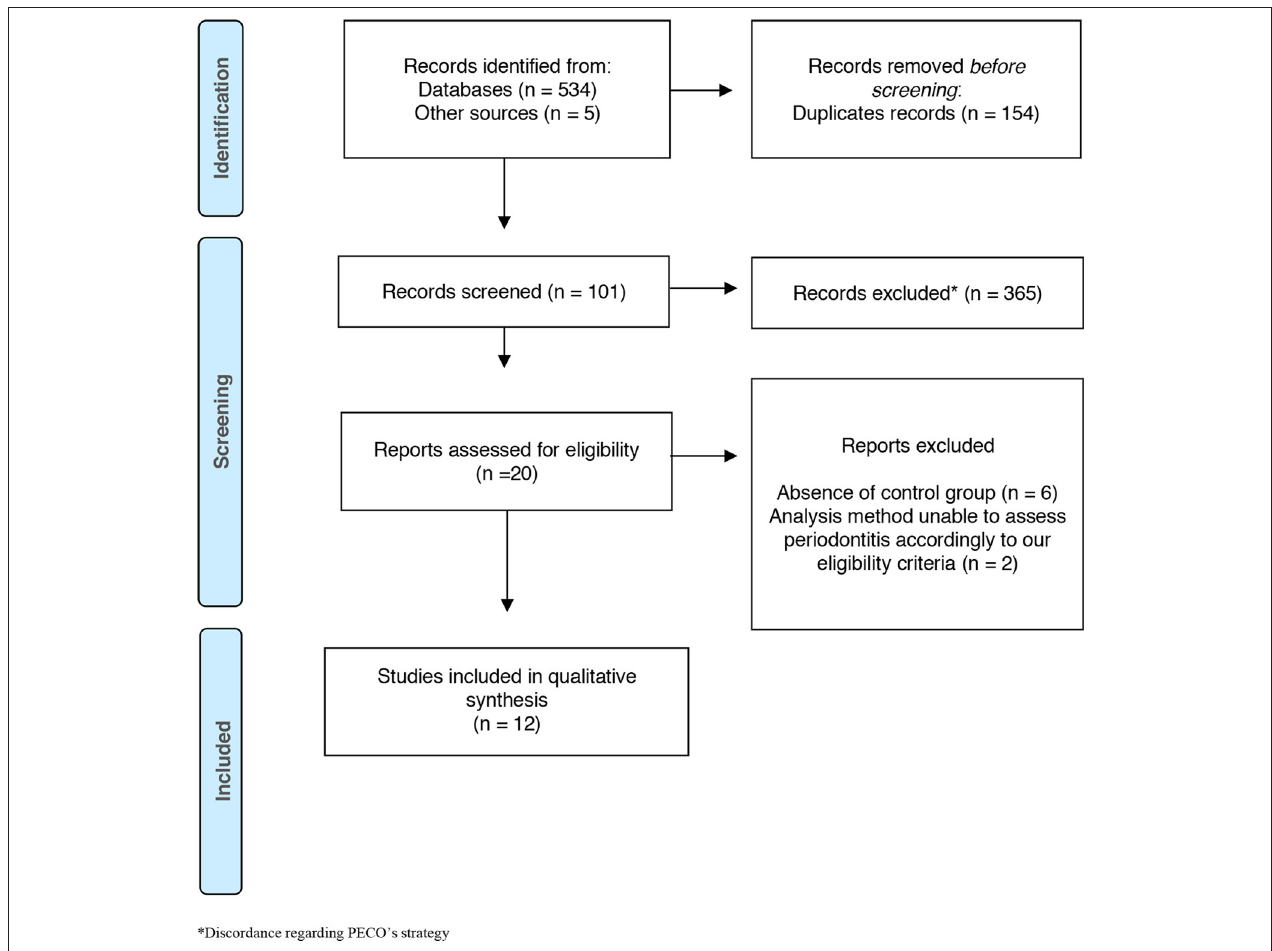
FIGURE 1 | Preferred Reporting Items for Systematic Reviews and Meta-Analyses (PRISMA) flow diagram of the different phases for exclusion and inclusion of the studies. *Discordance PECO’s